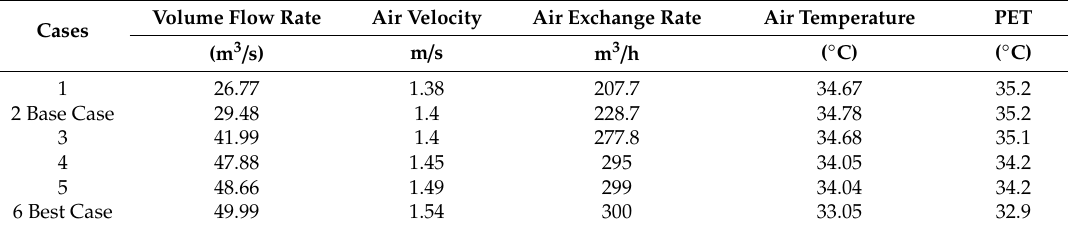
Table 10. The final environmental outcomes and PET comfort index for all the examined case studies.